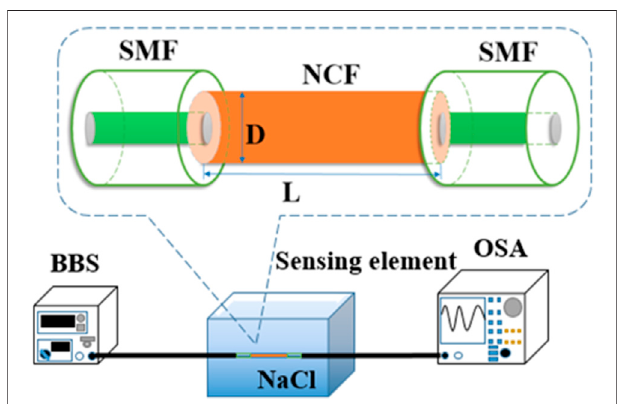
FIGURE 1 | Schematic diagram of SNS sensor